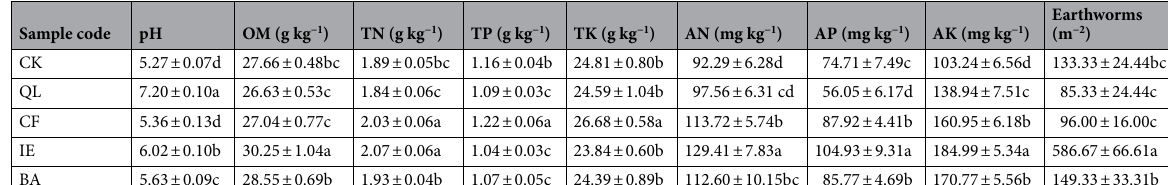
Table 1. Effects of different treatments on rhizosphere soil properties in continuous cropping lily. Date are presented as the Mean ± Standard Deviation (n = 3). Different letters within columns followed by